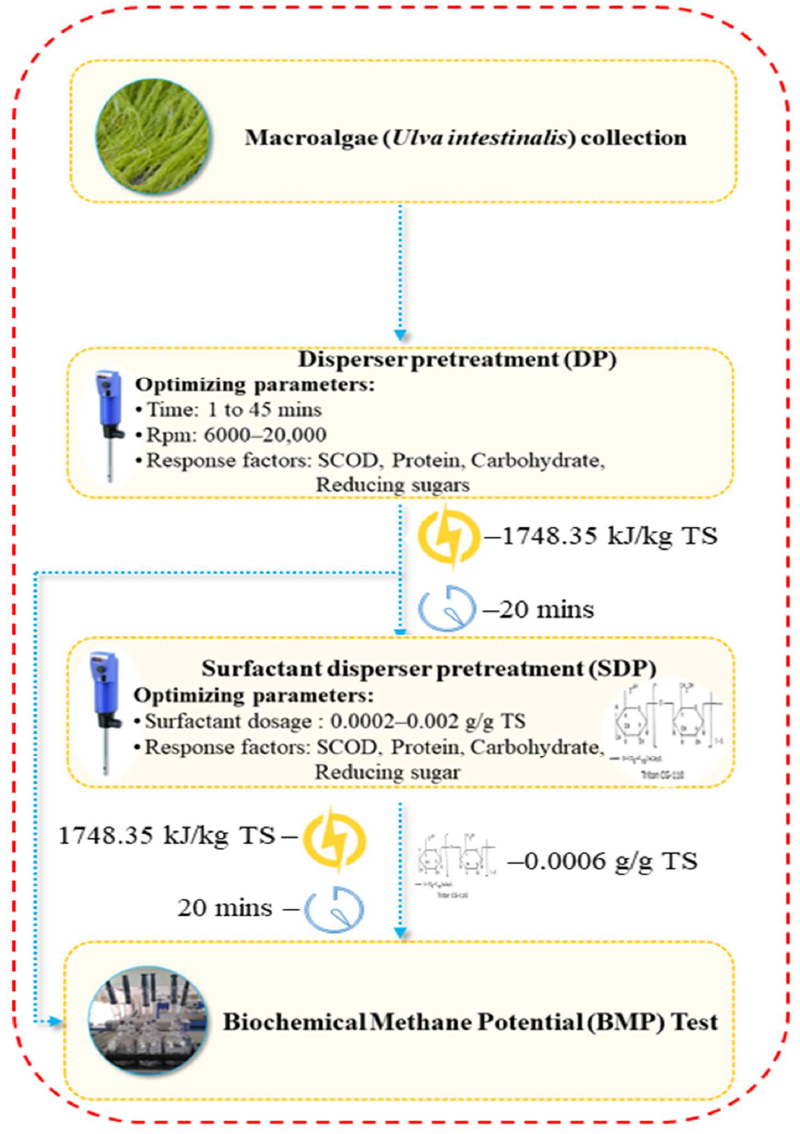
Figure 1. Graphical representation of the study.